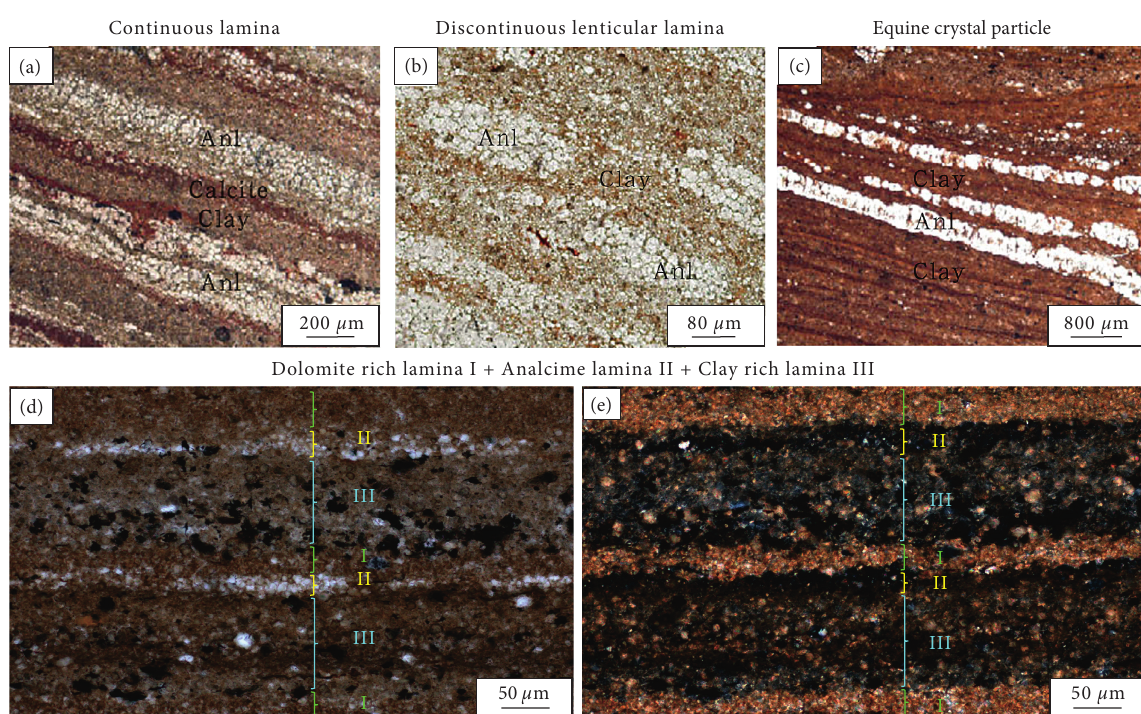
Figure 12: Analcime formed by precipitation from the alkaline lake or pore water. (a) Continuous lamina analcime [19]. (b) Discontinuous lenticular lamina analcime [19]. (c) Equine crystal particle analcime [19]. (d, e) Analcime distributed in a fixed pattern with other adjacent lamina.